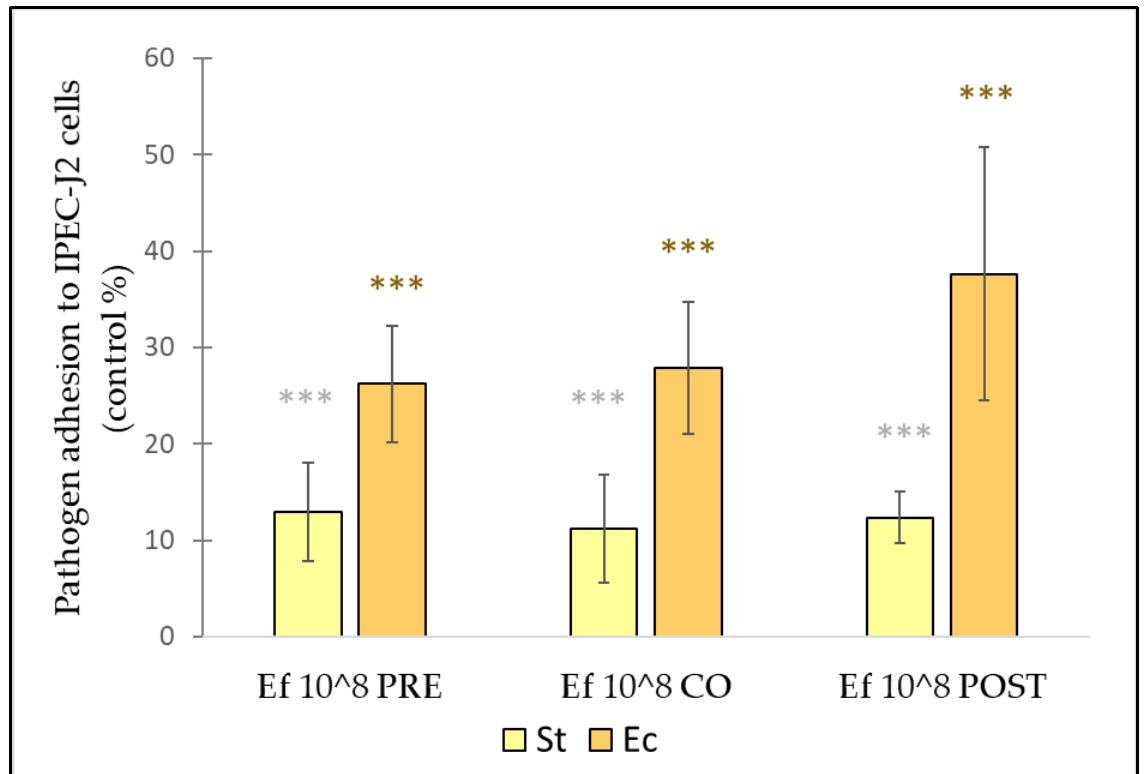
Figure 9. Inhibitory effect of E. faecium on E. coli and S. Typhimurium adhesion to IPEC-J2 cells. E. coli and S. Typhimurium adhesion inhibitions were determined upon incubation with E. faecium added 1 h before (pre-treatment), at the same time (co-treatment) and 1 h after (post-treatment) the addition of E. coli and S. Typhimurium, respectively. E. faecium was added in 10 8 CFU/mL. Ec : E. coli 10 6 CFU/mL ; Ef PRE : pre-treatment with E. faecium 10 8 CFU/mL + E. coli or S. Typhimurium 10 6 CFU/mL; Ef CO : co-treatment with E. faecium 10 8 CFU/mL + E. coli or S. Typhimurium 10 6 CFU/mL;